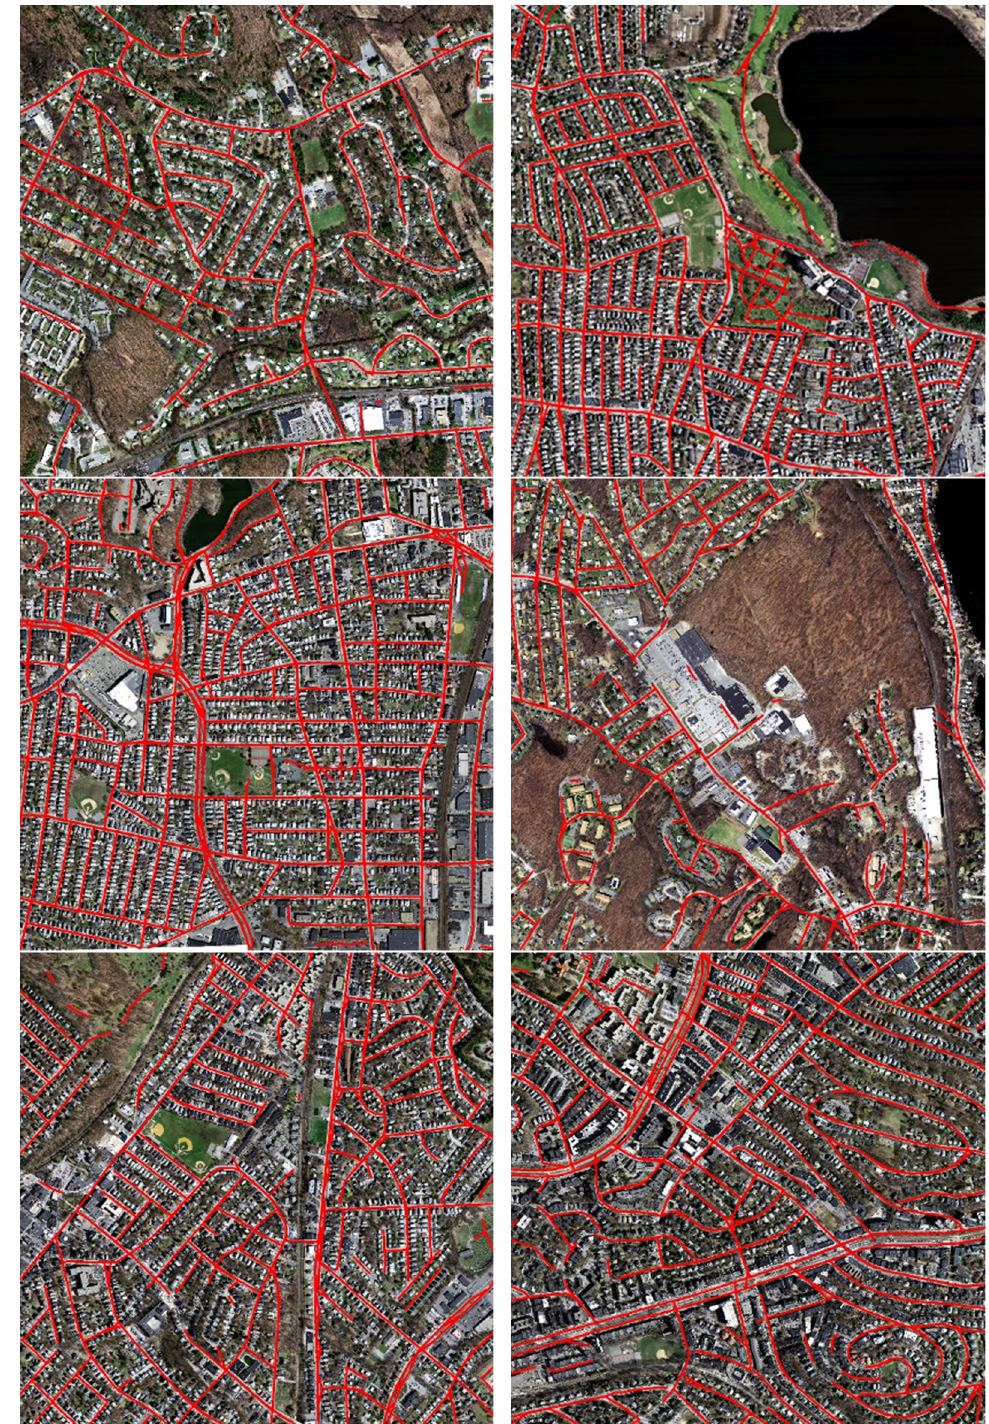
Figure 15. Visualization results of the proposed Bi-HRNet on the Massachusetts dataset with the model trained on the Google dataset.